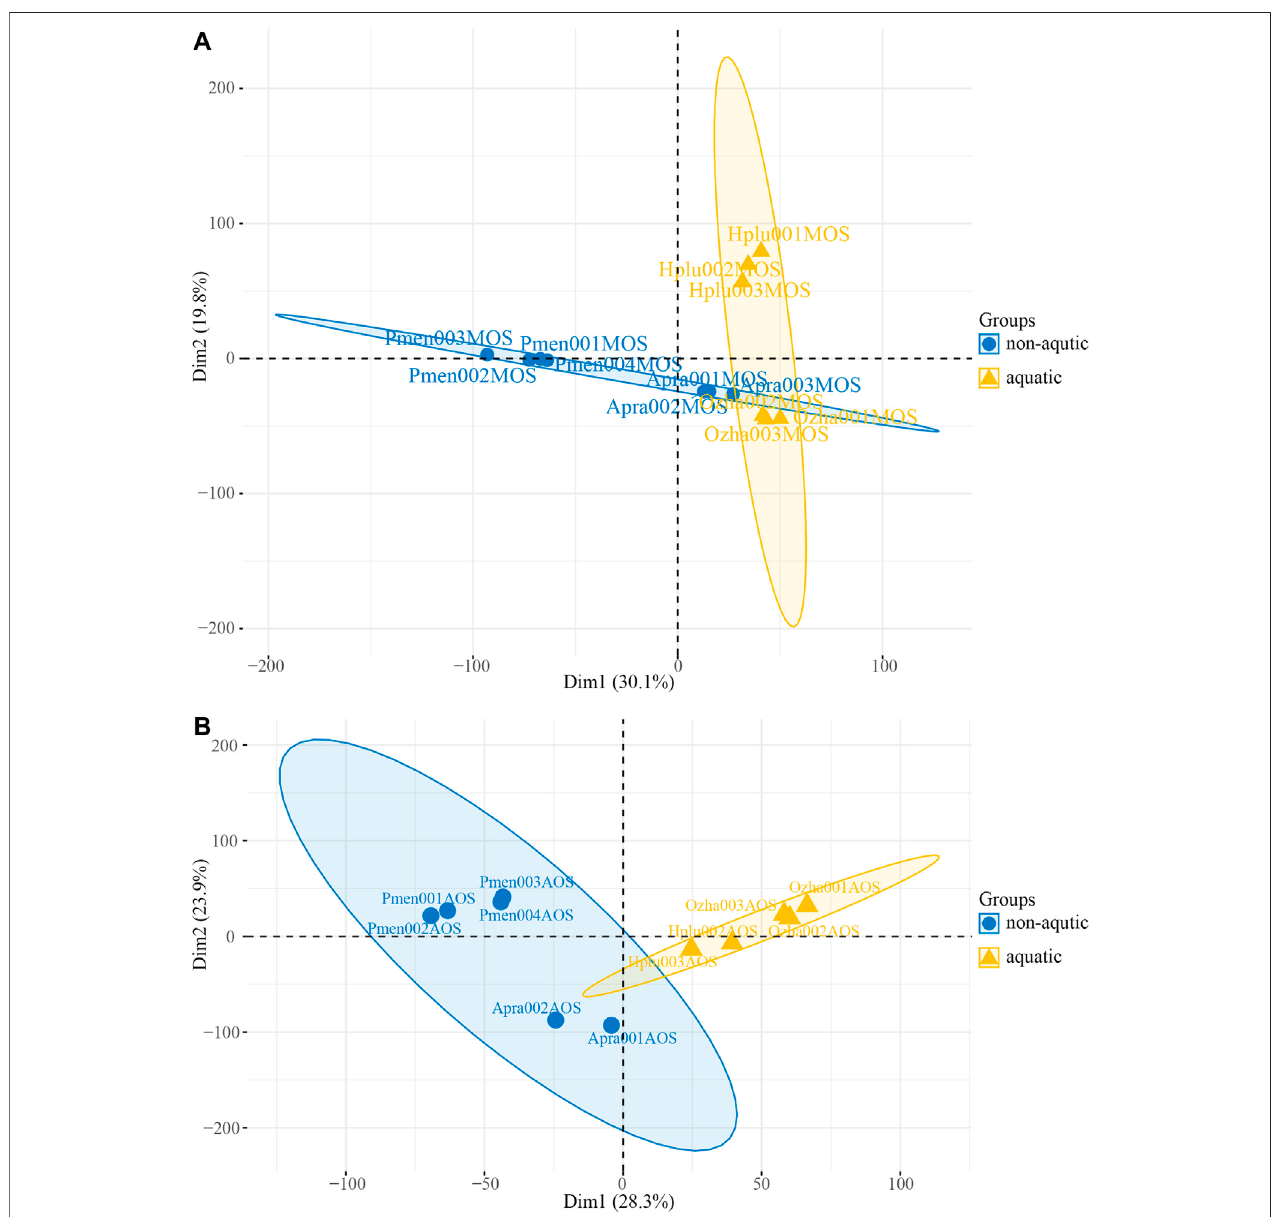
FIGURE 3 | Plot of the principal component analysis (PCA) of four species of snakes. (A) PCA plot of main olfactory system (MOS) samples. (B) PCA plot of accessory olfactory system (AOS) samples.